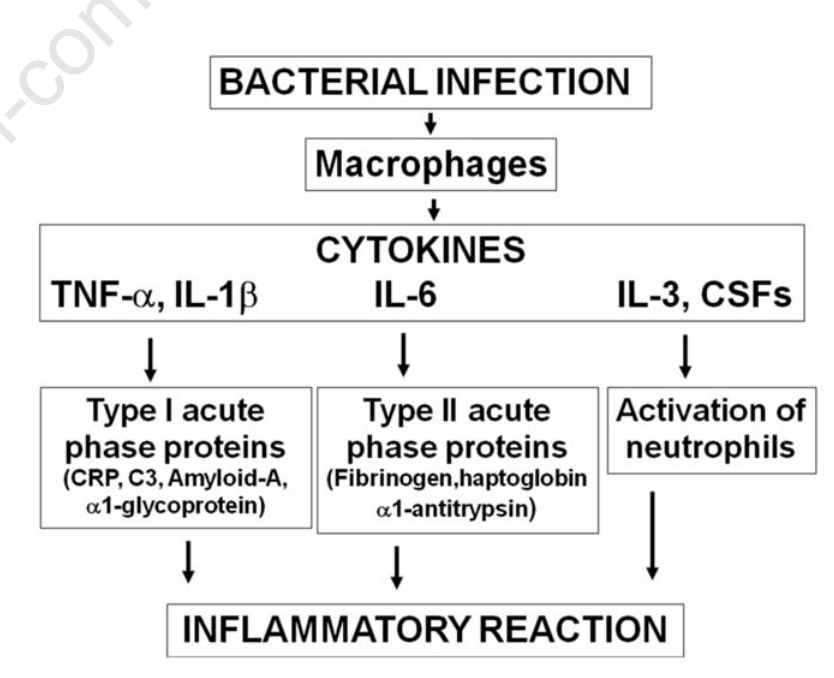
Figure 1. Inflammatory reaction during